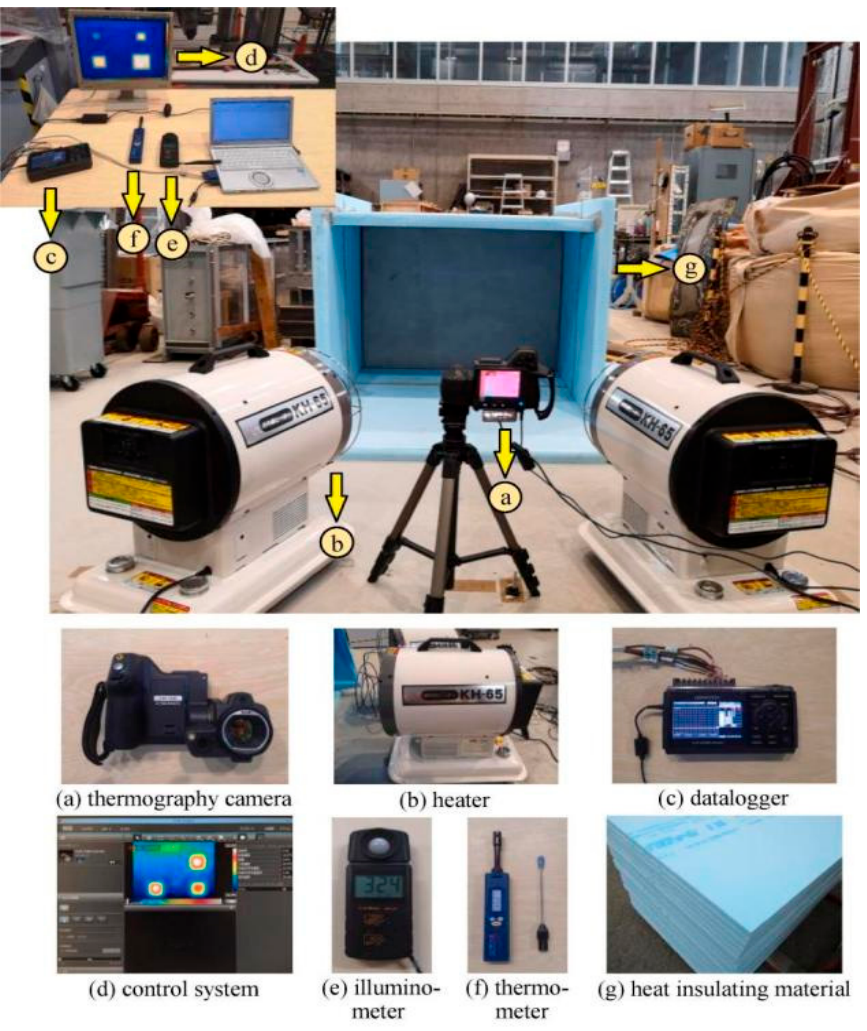
Figure 13. Setup of the experiment